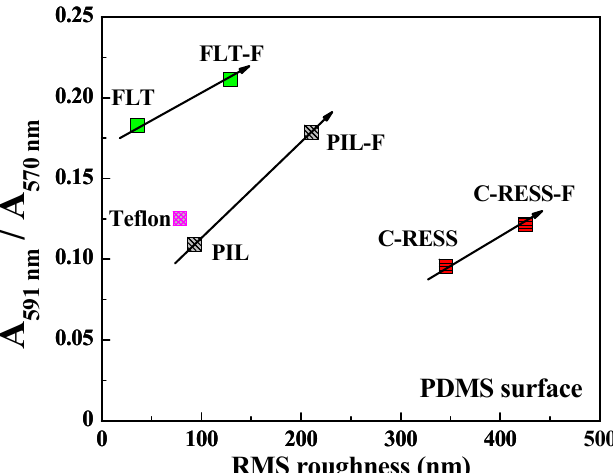
Figure 12. The effects of surface roughness of various PDMS patterns on the relative biofilm mass accumulation from the static biofilm formation per surface area ( ≈ 3.238 cm 2 ). Note that the E. coli was cultured with TSB medium for 24 h.